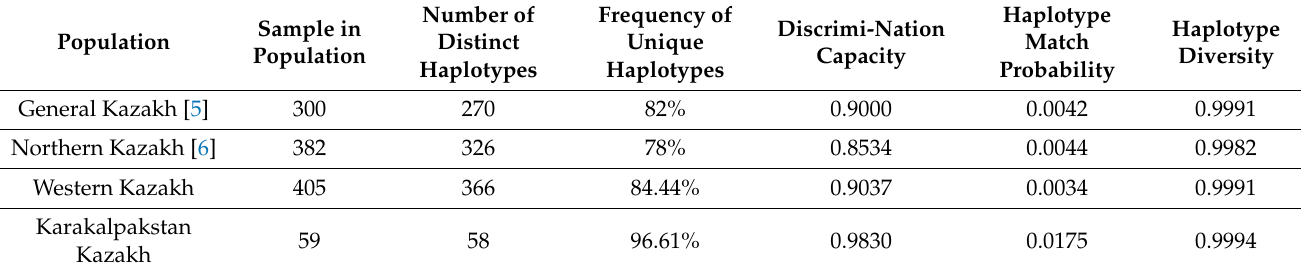
Table 1. Comparison of forensic parameters among Kazakh populations based on 27 Y-STR